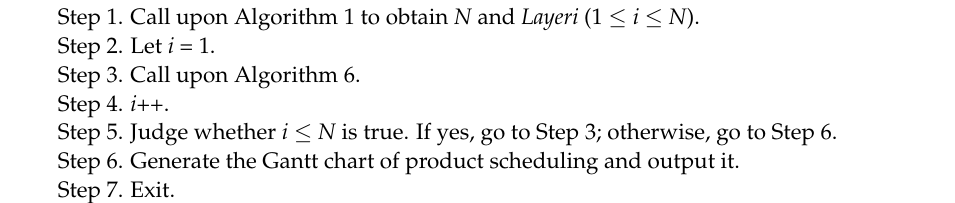
Algorithm 7 Proposed ROHISA, and its